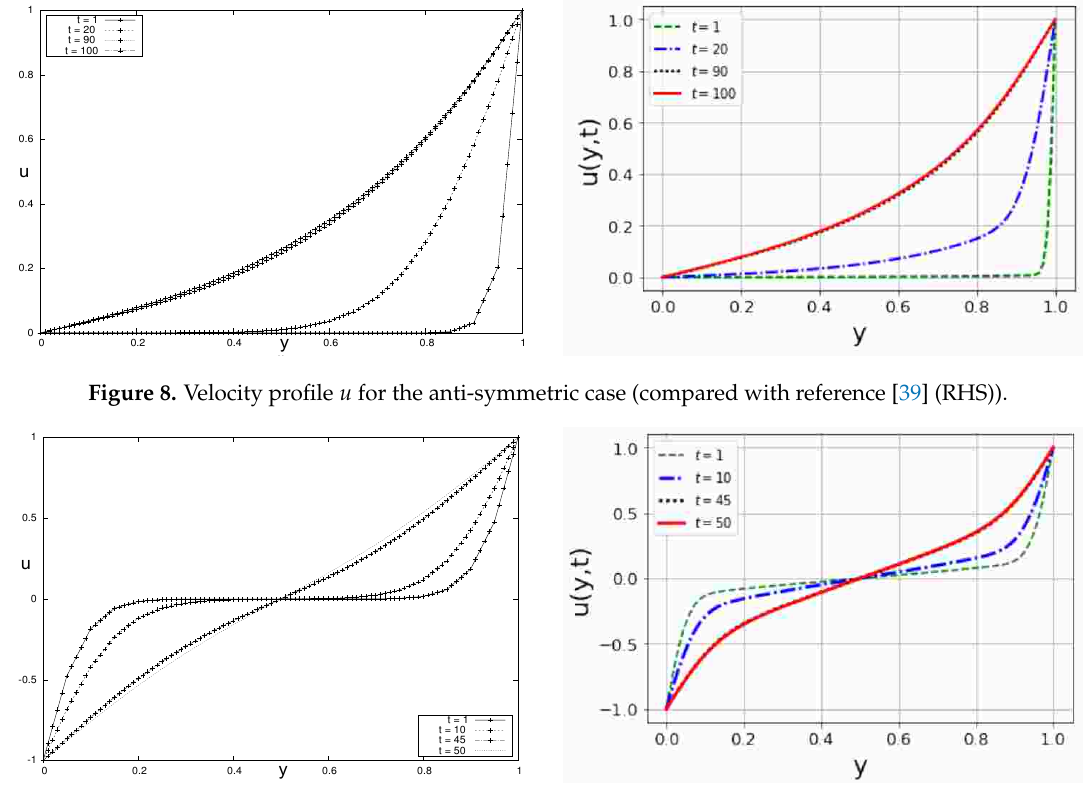
Figure 9. Velocity profile u for the symmetric case (compared with reference [39]